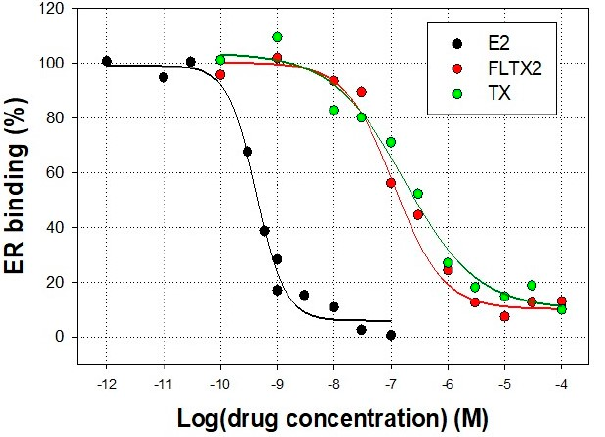
Figure 2. Effects of FLTX2 and TX on [ 3 H]-estradiol competitive ER binding assay. Uterine cytosolic extracts were saturated with 5 nM of labelled estradiol in the presence of increasing concentrations of unlabelled estradiol (E2), tamoxifen (TX), or FLTX2. Data are presented as mean ± SEM of four different assays.